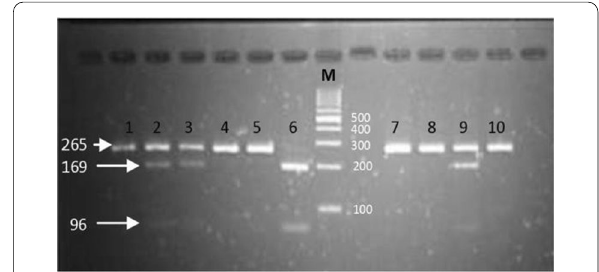
Fig. 1 Digestion product of rs2228570 with Fok1 enzyme, lane 1, 4, 5, 7, 8 and 10 CC, lane 2, 3 and 9 =